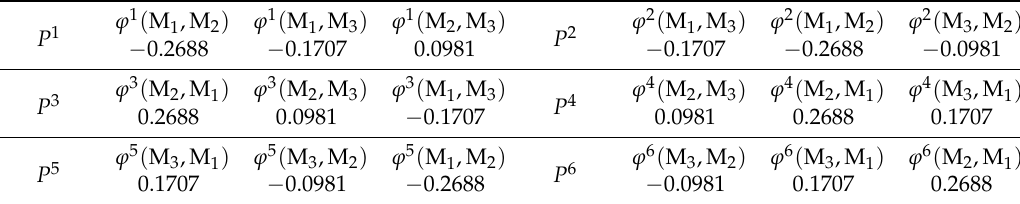
Table 4. The weighted concordance/discordance index.